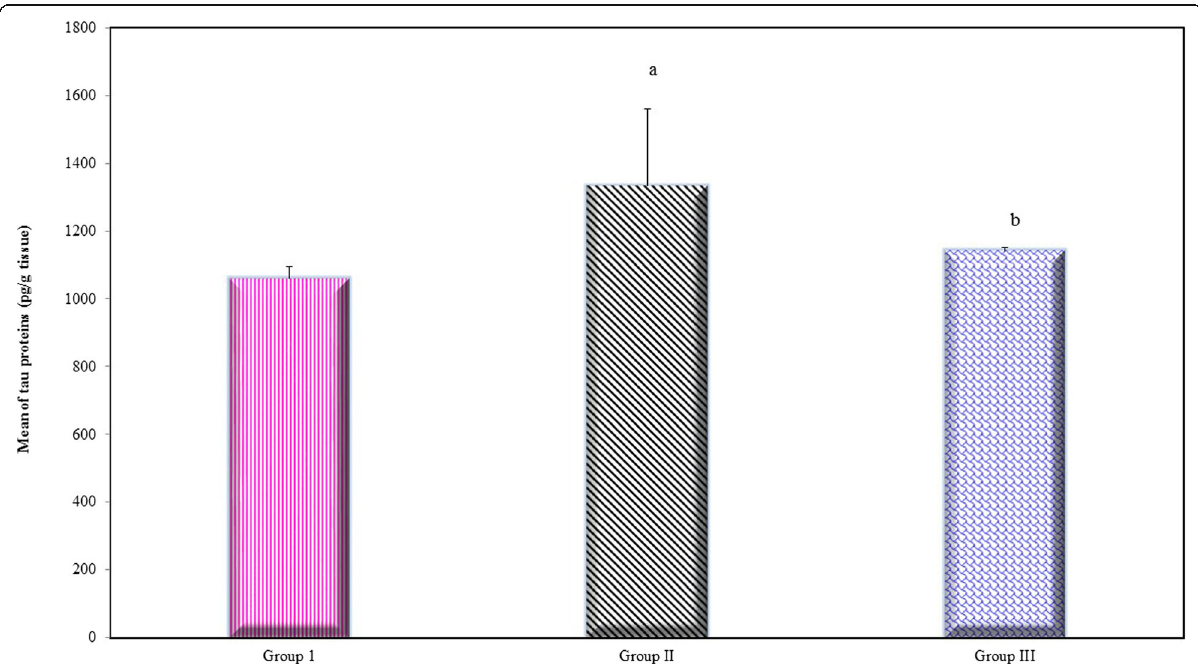
Fig. 3 Comparison between the three studied groups according to tau proteins (pg/g tissue). Group I, negative controls; Group II, STZ-induced AD, capsaicin untreated group (positive controls); Group III, STZ-induced AD+ capsaicin treated group; a, significantly different from the negative controls (group I); b, significantly different from the positive controls (STZ-induced AD, capsaicin untreated) (group II)